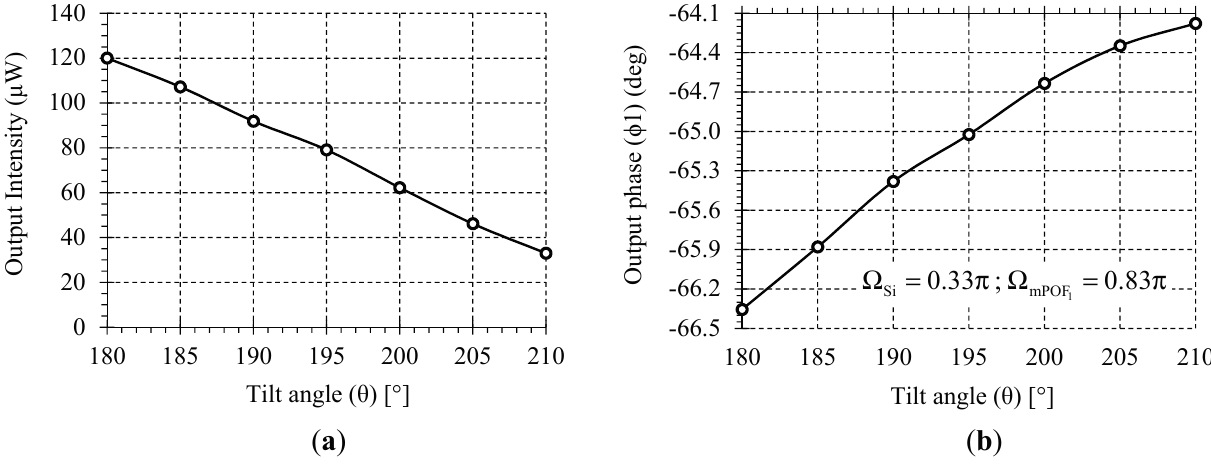
Figure 10. ( a ) Light intensity versus fiber tilt angle [18]; ( b ) Output phase parameter